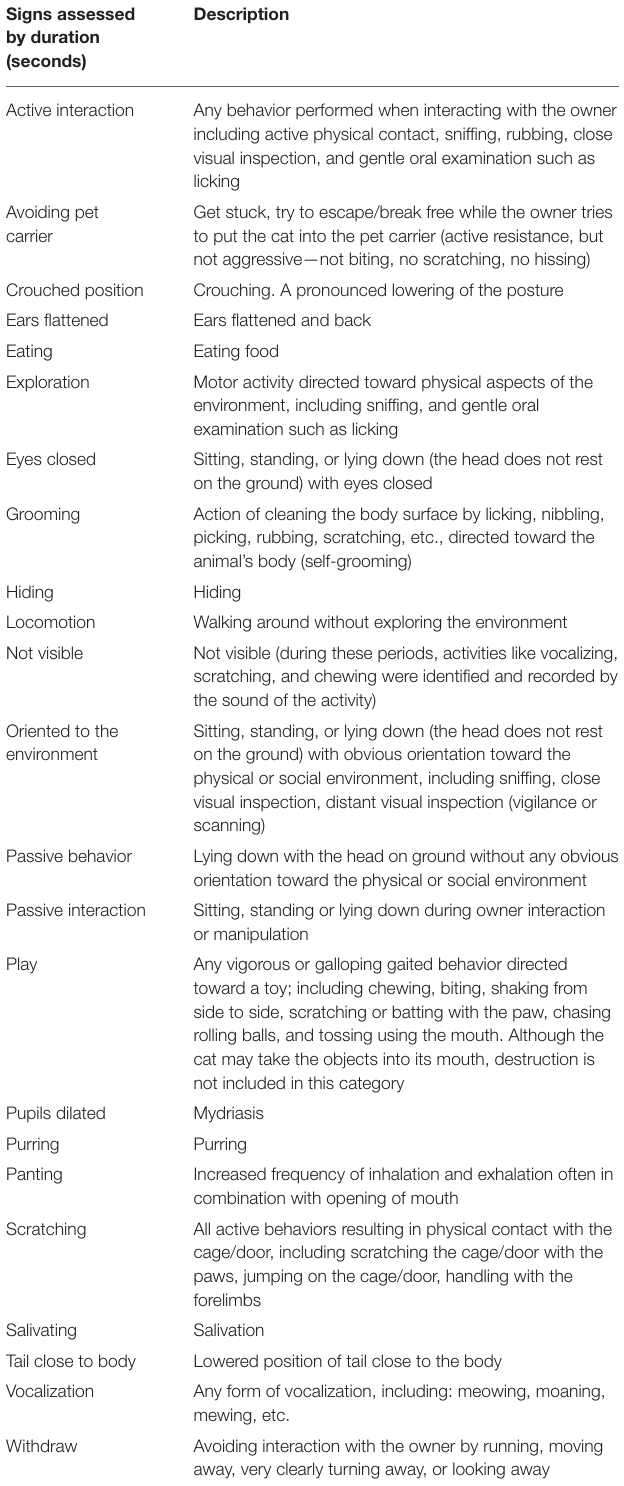
TABLE 2 | The ethogram used by the external observer for video assessment of cats. Signs assessed by duration (seconds)